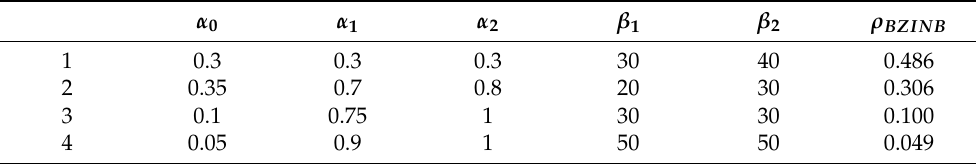
Table A2. Shape and scale parameters used to obtain various values of correlation for BZINB simulation for vector pairs that represent pairs of species. The number labels of each line denote the parameters used to obtain results for each line of Appendix A Table